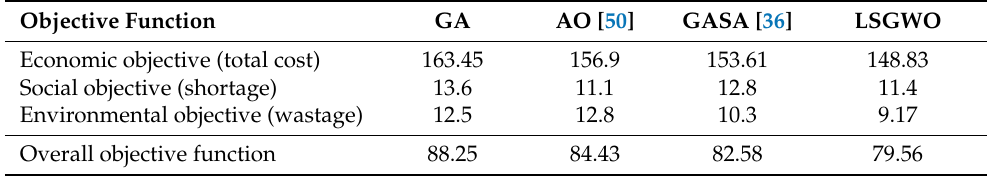
Table 8. Comparison of the different objectives for different algorithms (in